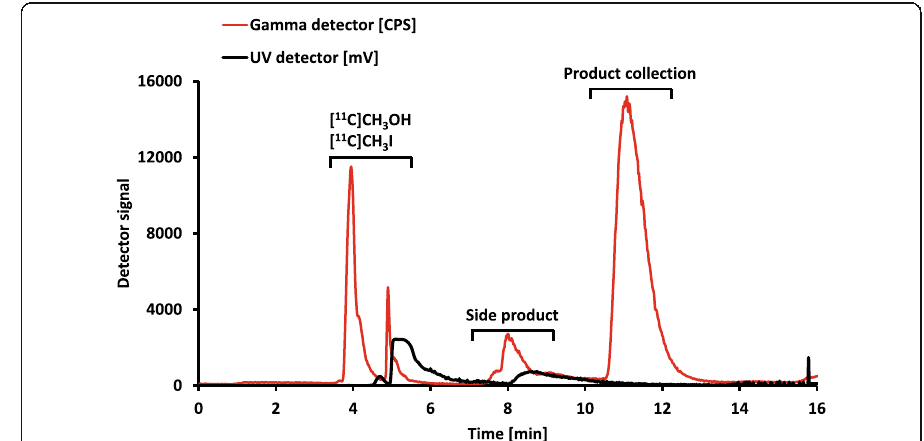
Fig. 3 Typical semi-preparative RP-HPLC chromatogram of a [ 11 C]metoclopramide radiosynthesis including the signal of the UV-detector (254 nm, black) and radio-detector (red). The product peak has a retention time of approximately 10.5 – 12.5